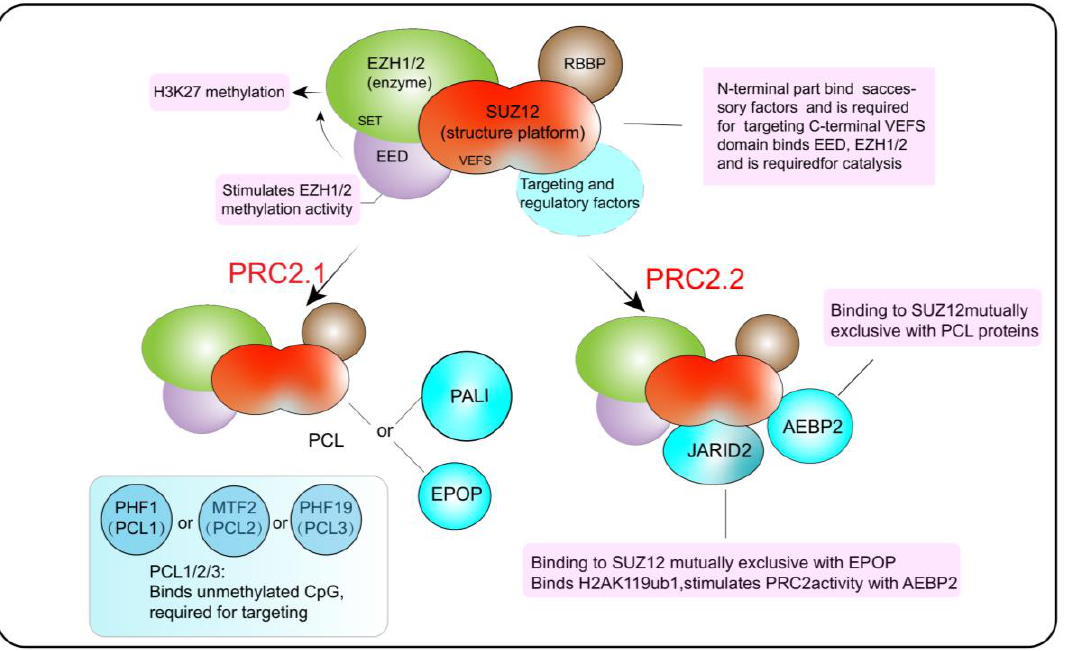
Figure 2. Comparisons of different groups of PRC2 complexes. Illustration of core and accessory subunits composing canonical and variant PRC2 complexes.